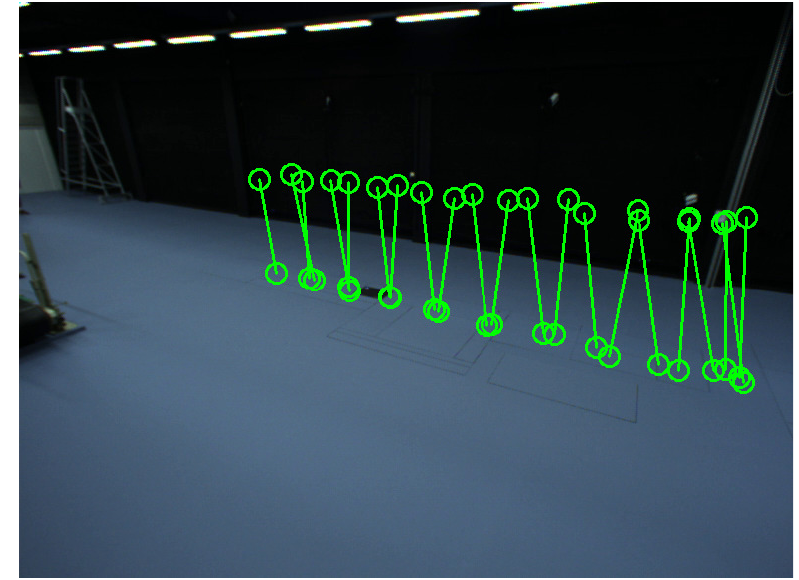
Figure 12. Distribution of the person’s positions for Camera Network 2. Green circles represent detected positions using ellipse